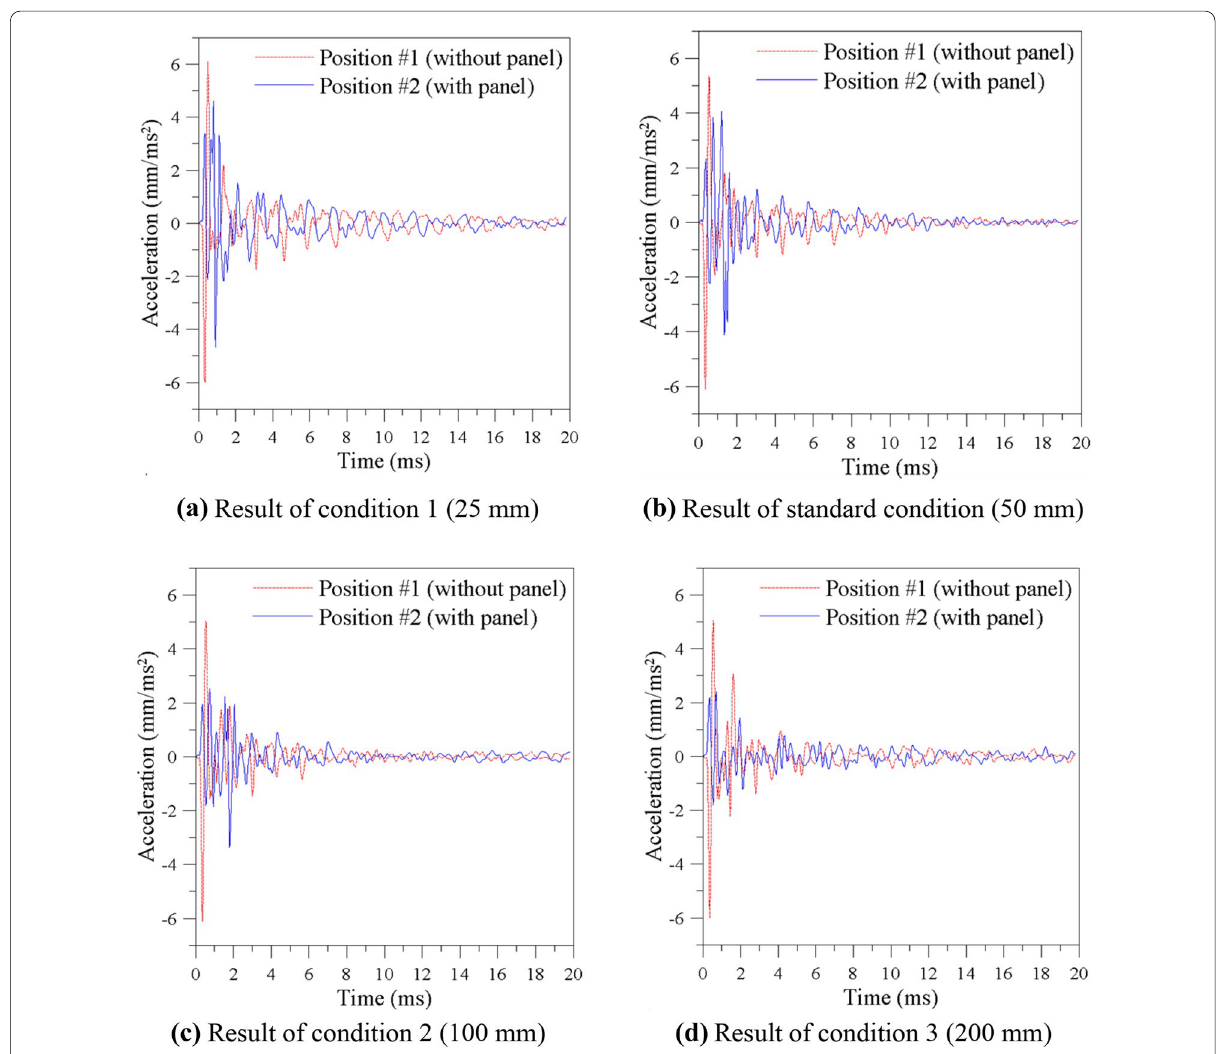
Fig. 17 Acceleration measured at outside wall according to blast‑proof panel thickness for normal strength